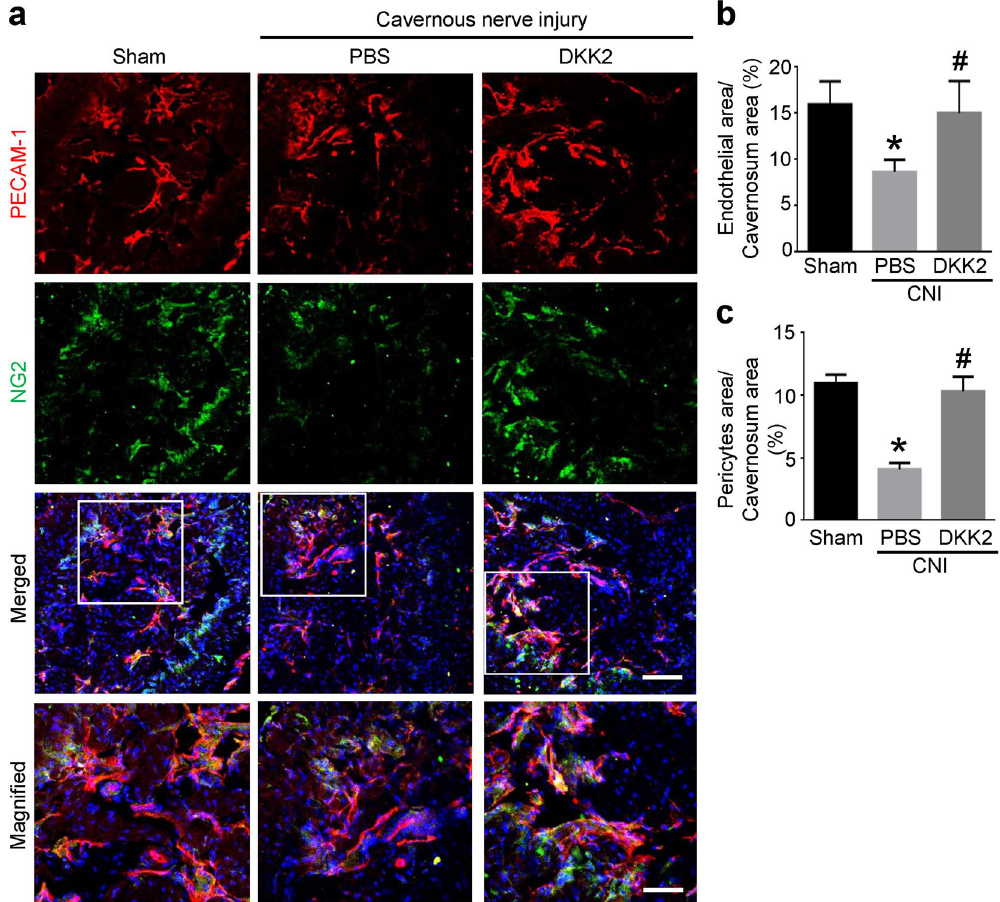
injections of PBS (20 μ l) or DKK2 protein (days -3 and 0; 6 µ g/20 µ l). Nuclei were labeled with DAPI (blue). Scale bar 100 µ m (upper row), and 25 µ m (lower row). (b , c) Quantitative analysis of cavernous endothelial cell and pericyte content was performed by an image analyzer. Each bar depicts the mean ( ± SE) values from n = 6 animals per group. * P < 0.05 vs. sham operation group, # P < 0.05 vs. PBS-treated CNI group. CNI = cavernous nerve injury; DKK2 =